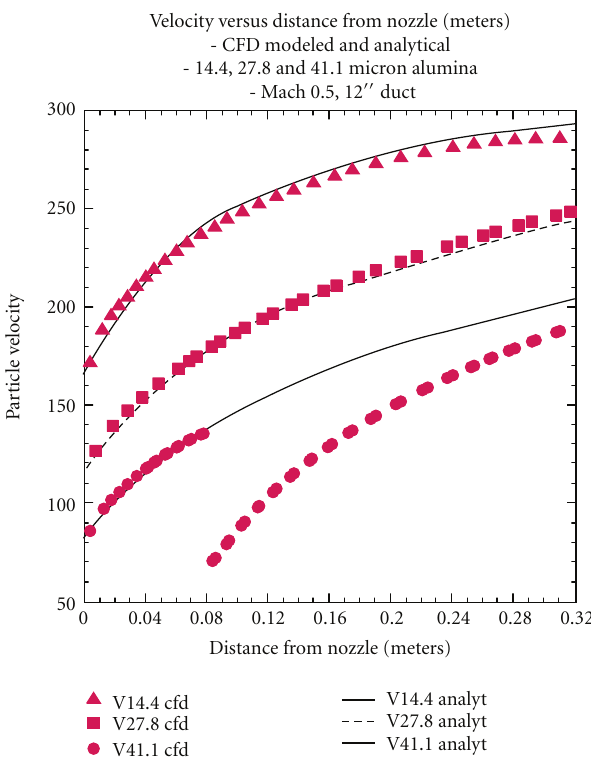
Figure 9: Comparison of particle velocity for particles with three di ff erent diameters obtained from model predictions with that obtained from an analytical expression of particle velocity with nonzero initial velocity in a Mach 0.5 burner rig (0.305m long